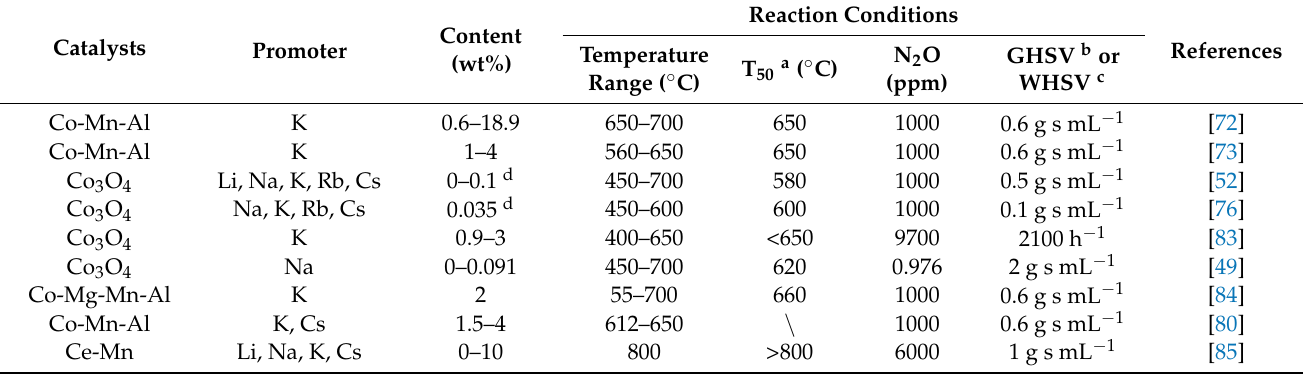
Table 3. Summary of catalysts and reaction conditions for NO decomposition promoted by alkali